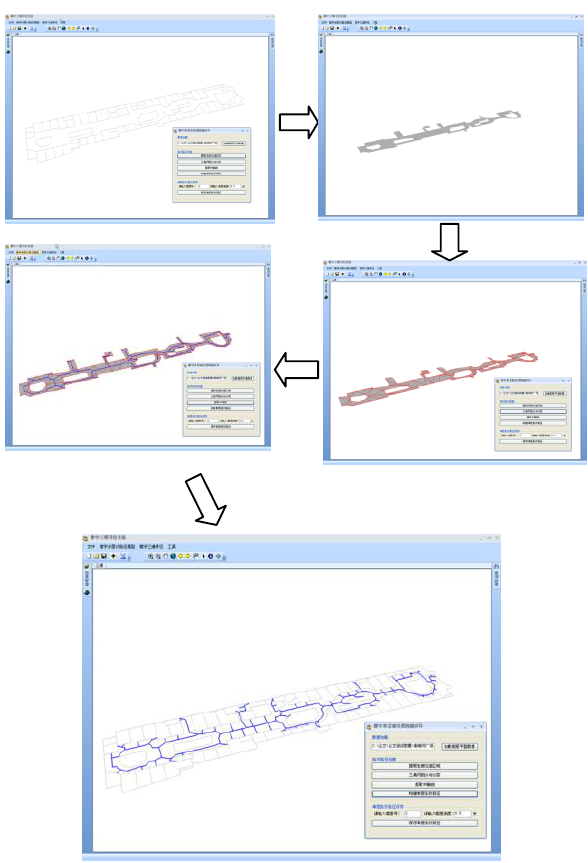
Figure 9 The result of route modelling for single floor in Longjiang New City